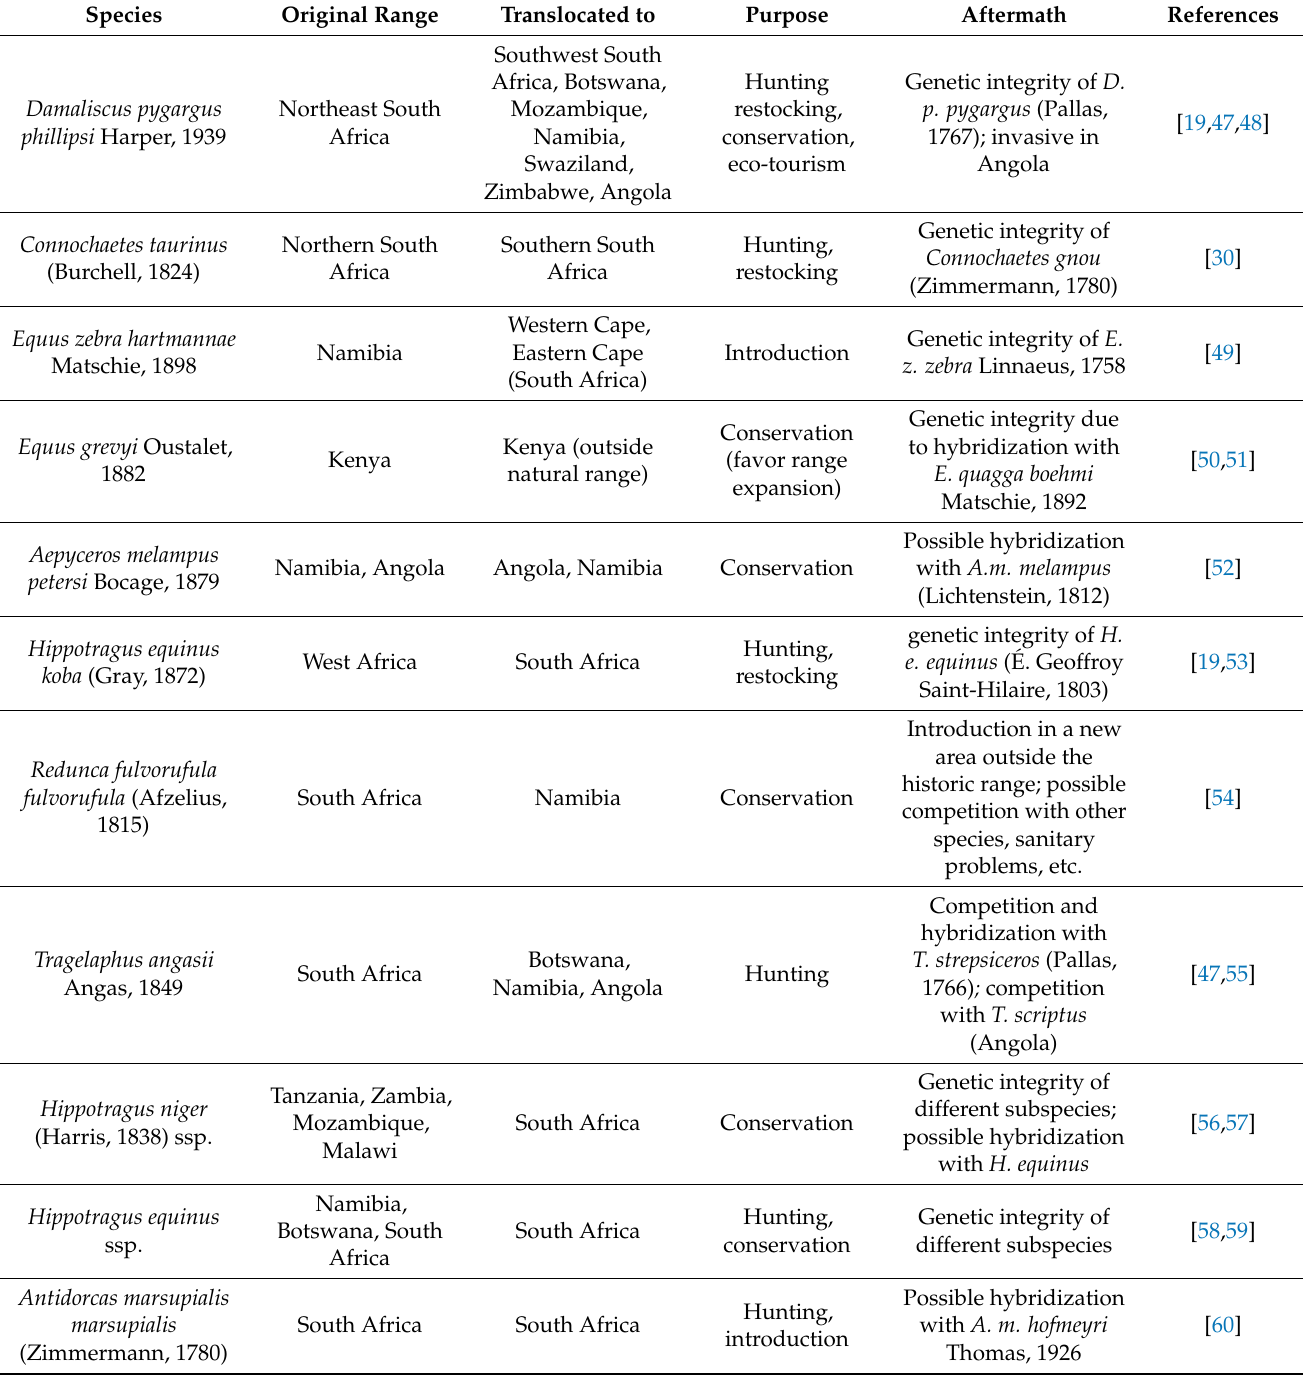
Table 1. Some selected cases of mammalian translocations in Africa, with uncertain outcomes, including goals and consequent problems. Taxonomy follows predominantly